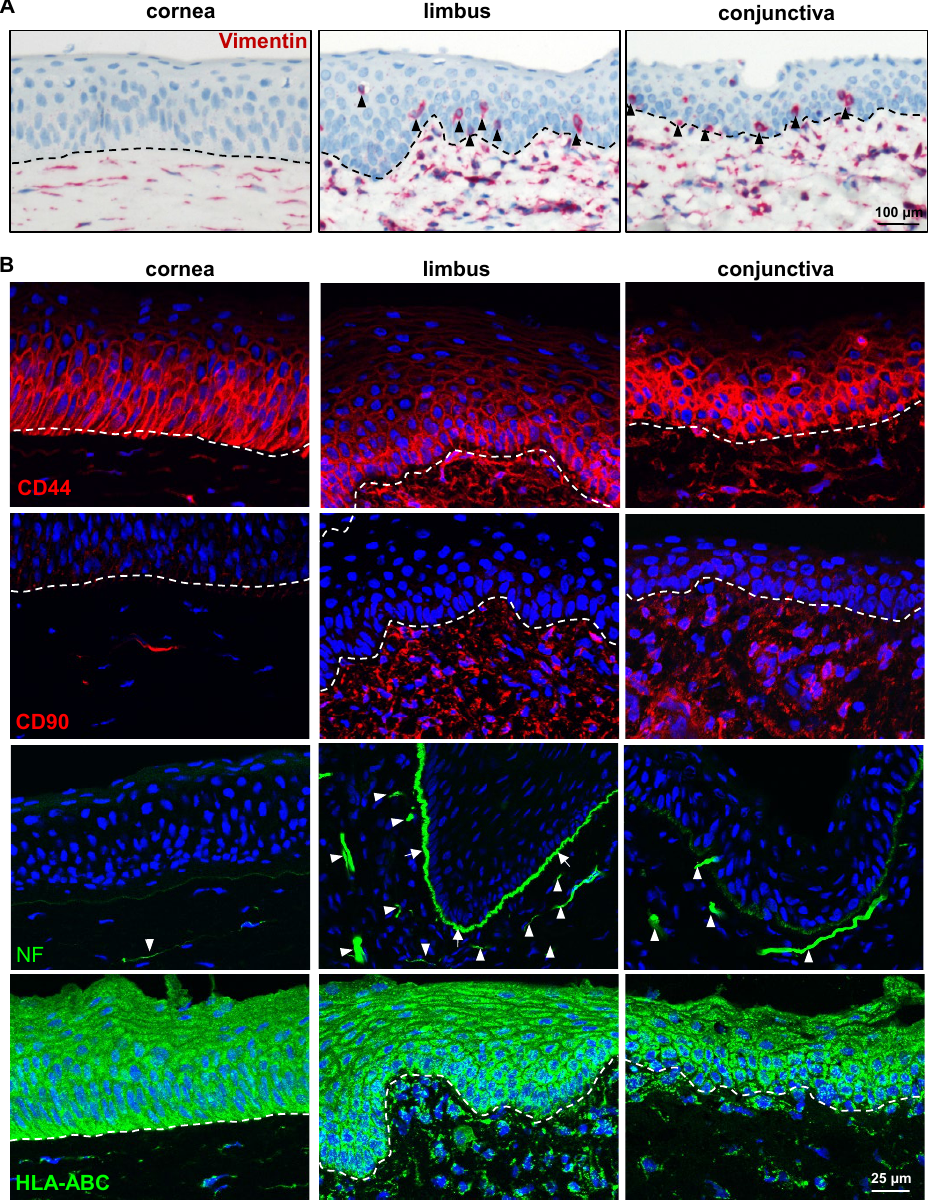
Figure 5. Expression analysis of limbal niche cell - related markers: ( A ) Immunohistochemical staining of paraffin sections of corneoconjunctival specimen showing the vimentin expression in the stromal cells of the porcine cornea, limbus, and conjunctiva (red); vimentin + cells in the basal epithelial layers of both limbus and conjunctiva (arrowheads); dashed line represents the basement membrane (BM). ( B ) Immunofluorescence staining corneoconjunctival tissue sections showing the CD44 expression on the plasma membranes of basal epithelial and stromal cells of the cornea (red) and predominant expression in the limbus and conjunctiva; CD90 expression in the stromal cells of limbus and conjunctiva (red); neurofilament (NF) expression in the stroma of all three surface regions (arrowheads) and in the limbal BM (arrowheads); the anti - human HLA - class I antibody stained all cells of the ocular surface (dashed line represents BM).